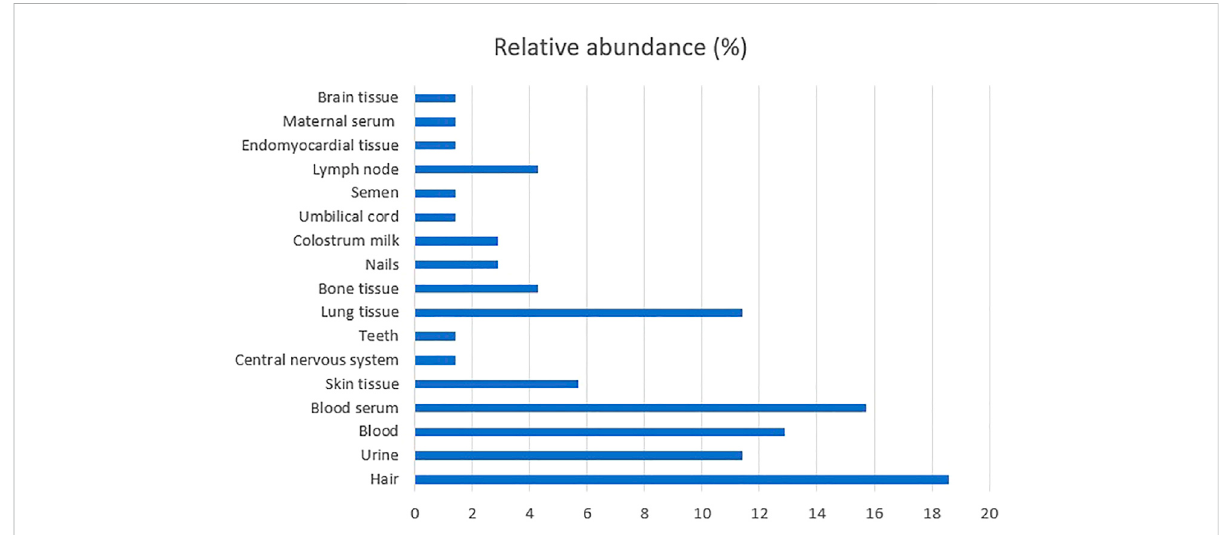
FIGURE 2 Comparison of number of available articles in which each biological matrices was analyzed for the toxicity of REEs.